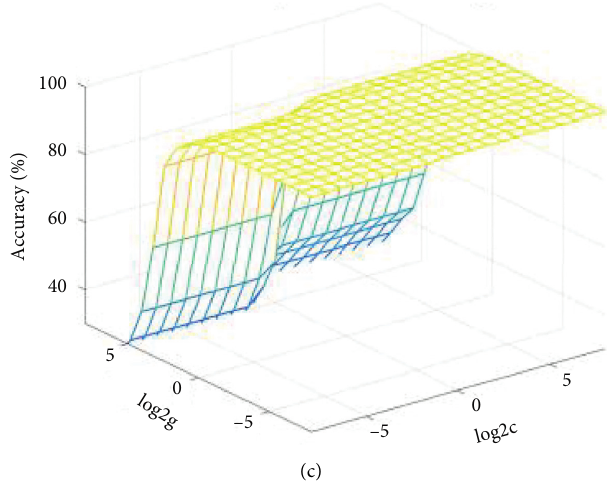
Figure 4: Result of GS-SVM parameter selection. (a) Result of No-GS-SVM parameter selection (best c � 0.32988, best g � 1, and CVAccuracy � 99.5833%). (b) Result of PCA-GS-SVM parameter selection (best c � 0.32988, best g � 0.32988, and CVAccuracy � 99.7917%). (c) Result of t-SNE-GS-SVM parameter selection (best c � 0.18946, best g � 0.011842, and CVAccuracy �